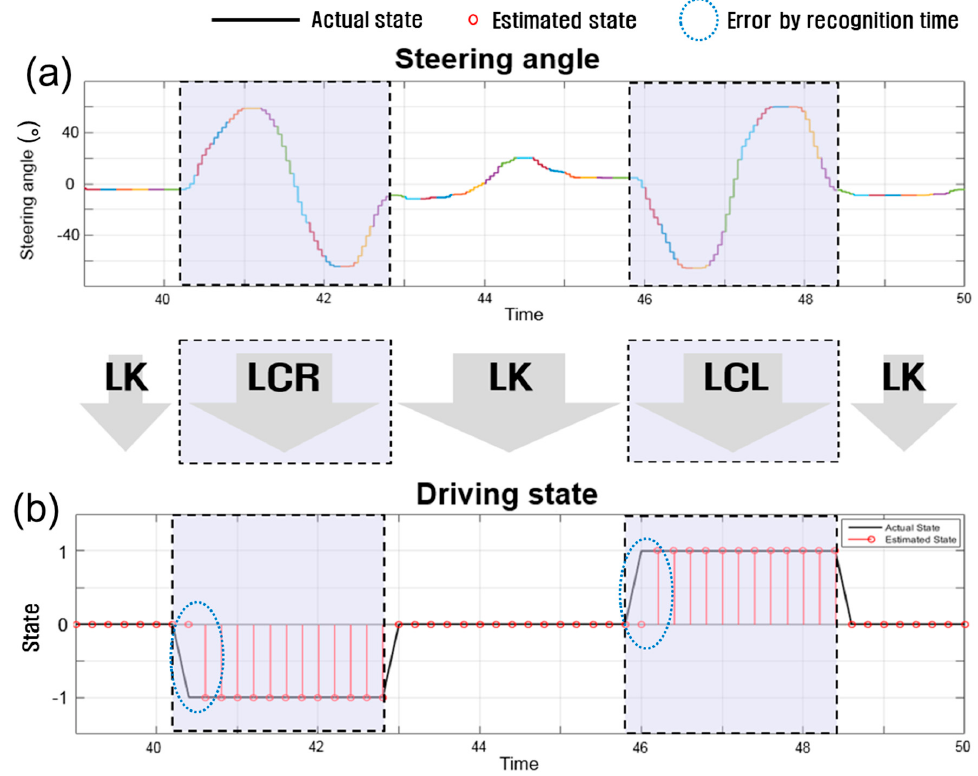
Figure 16. Lane change maneuvers and driver’s intention: ( a ) steering wheel angle; and ( b ) driving state ( − 1 is LCR, 0 is LK, 1 is LCL). state ( − 1 is LCR, 0 is LK, 1 is